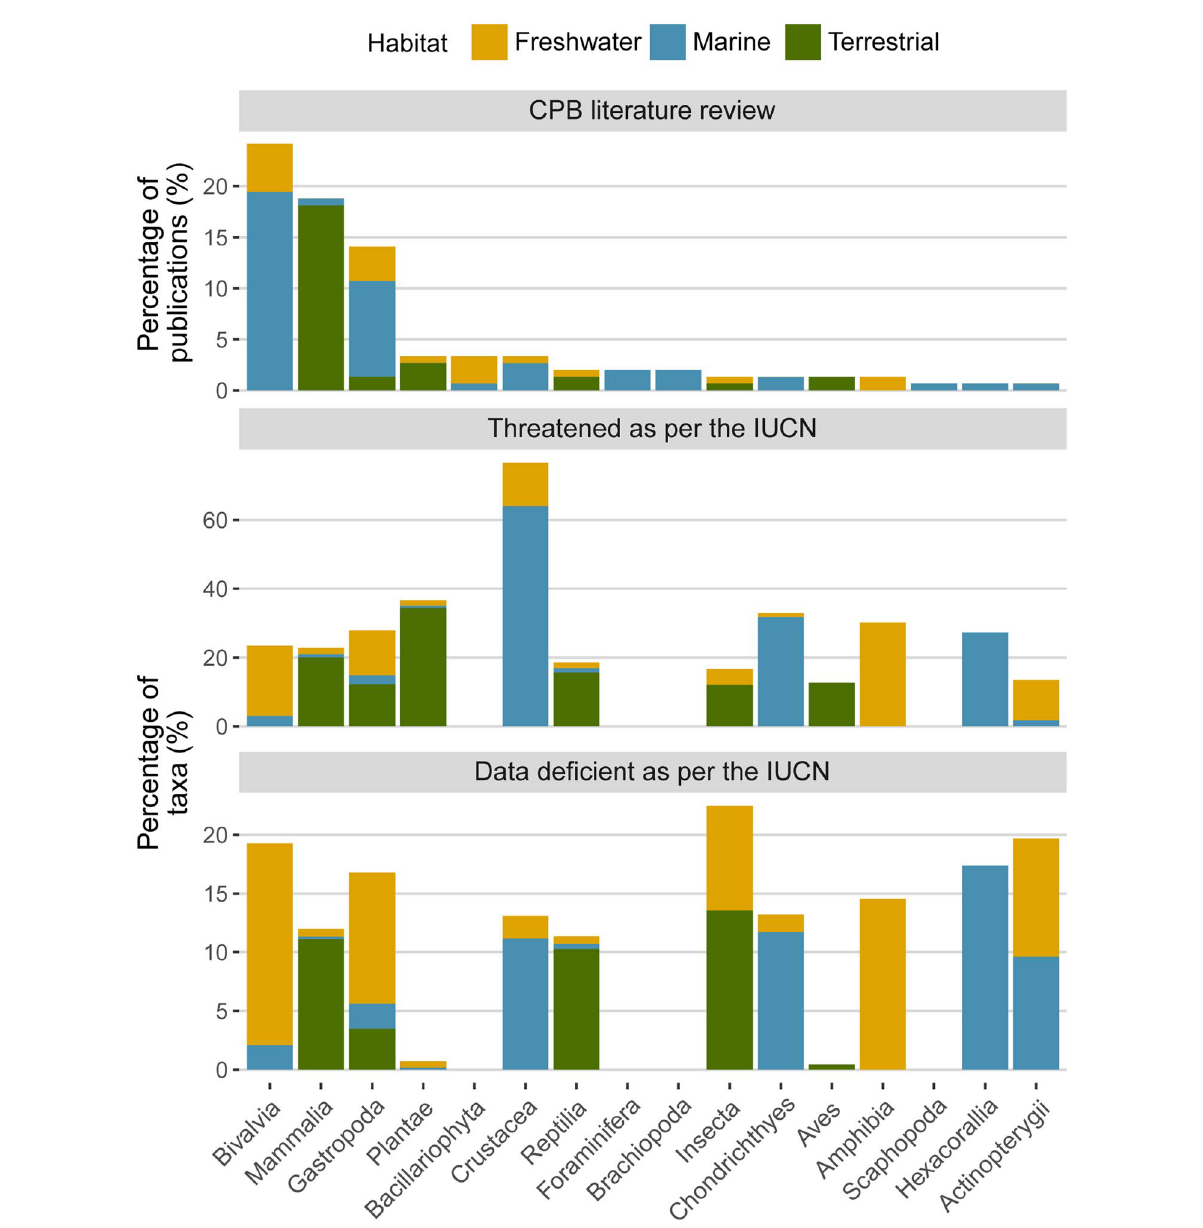
FIGURE 5 Taxonomic representation of publications in the literature review relative to extinction risk. For each taxonomic group, we compared the percentage of publications in the literature review that focused on that group (top) with the percentage of threatened species (center) and the percentage of data-deficient species (bottom) assessed by the IUCN Red List (IUCN, 2022). Molluscs and mammals were overrepresented in CPB research relative to their extinction